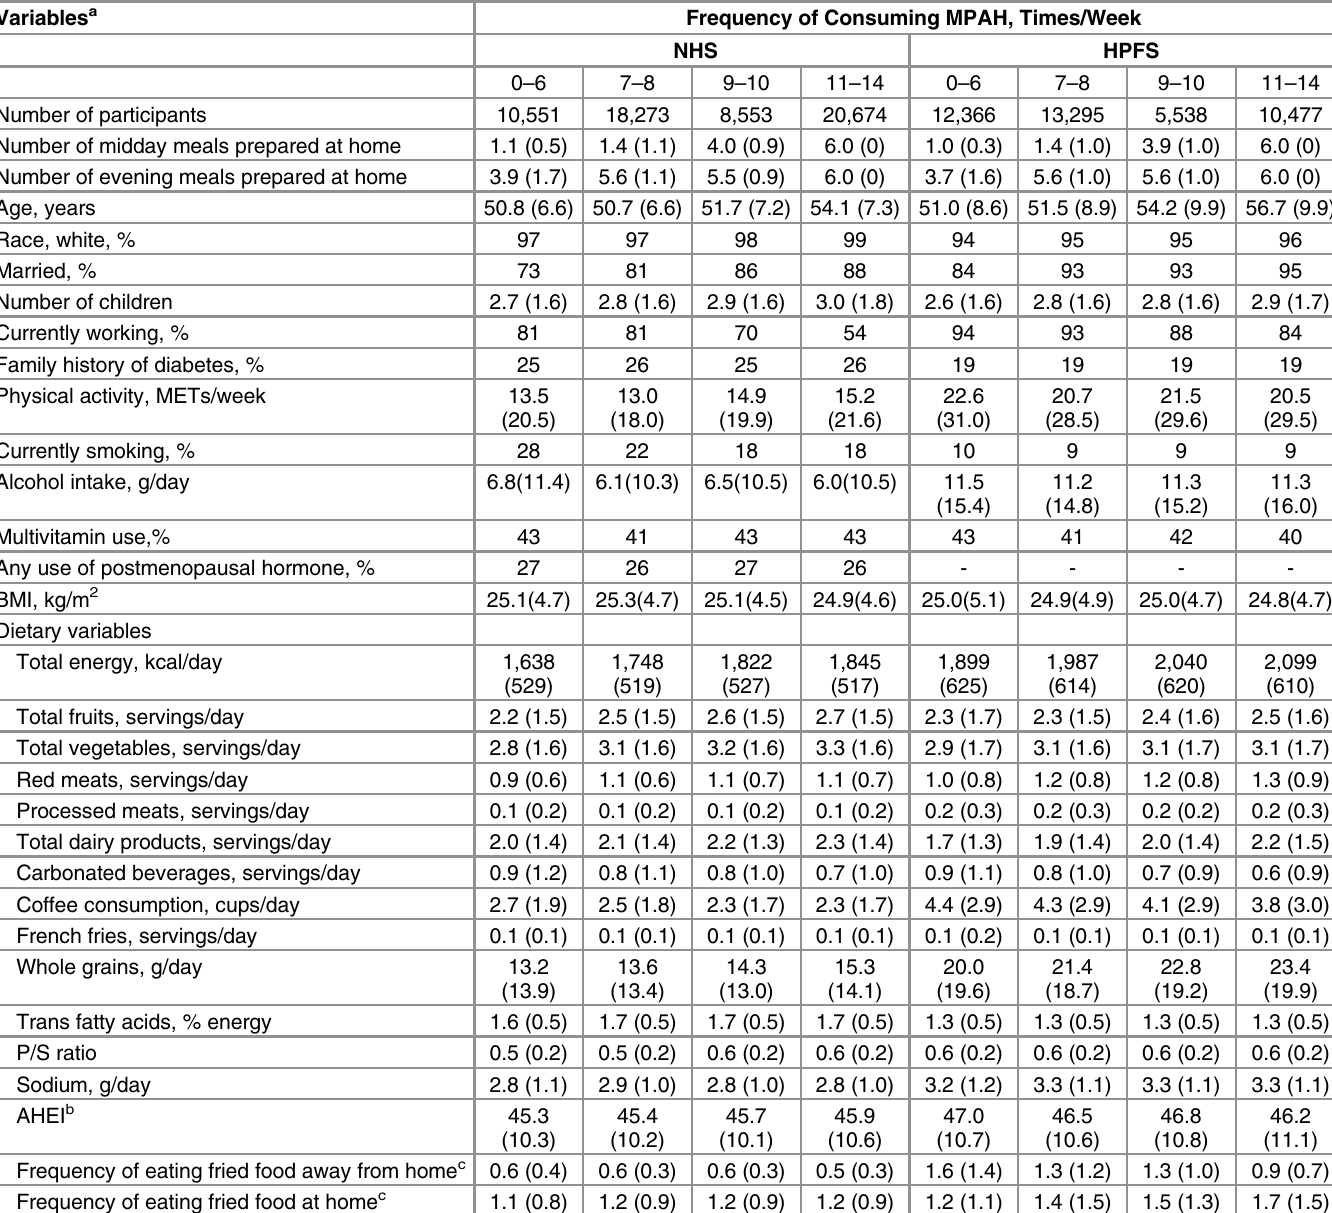
Table 1. Baseline characteristics in the NHS and the HPFS (1986) according to frequencies of consuming